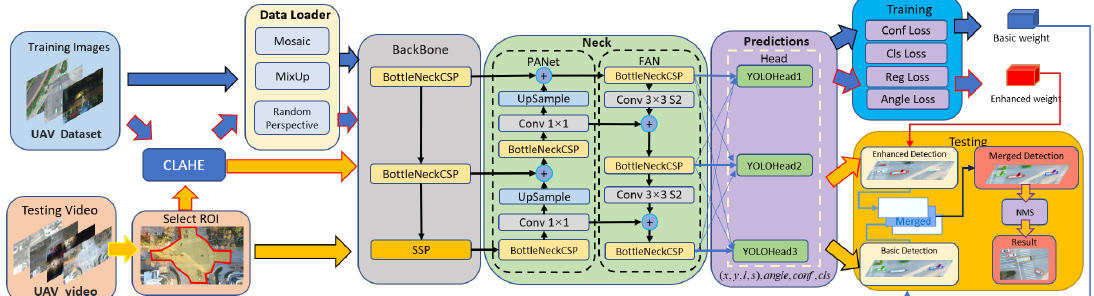
Figure 2. Structure of the dual-weight YOLOv5-OBB algorithm with